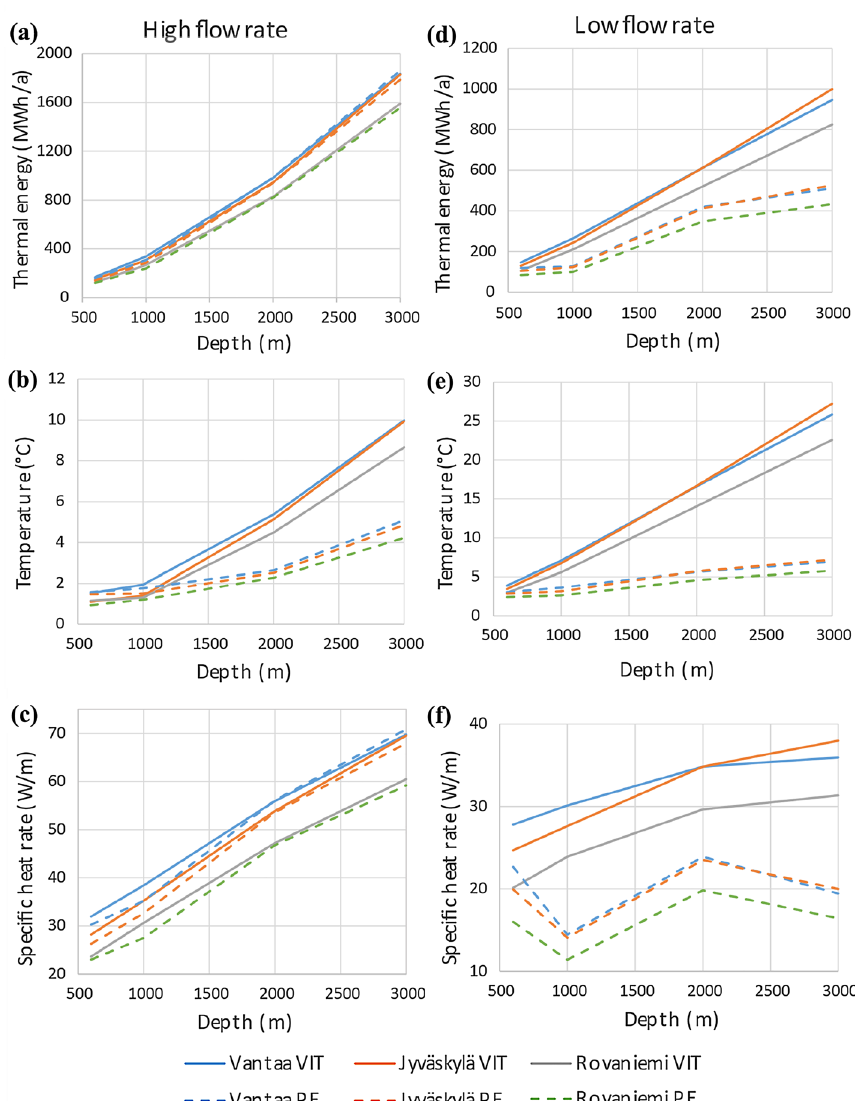
Fig. 3 Comparison of thermal energy produced by constant heat extraction over 25 years, with the outlet temperature and specific heat rate at high and low flow rates for each modelled depth, location, and two collector pipe types. The highest flow rates for VIT are 5 L/s at all pipe lengths, while for HDPE pipe they are 5 L/s at 1 km and 10 L/s at 2 km and 3 km. The lowest flow rates are 1 L/s for VIT at all pipe lengths and for 1 km of HDPE pipe, and 2 L/s for 2 km and 3 km HDPE pipe. Because flow rate is not similar in all cases, the solid and dashed lines do not represent